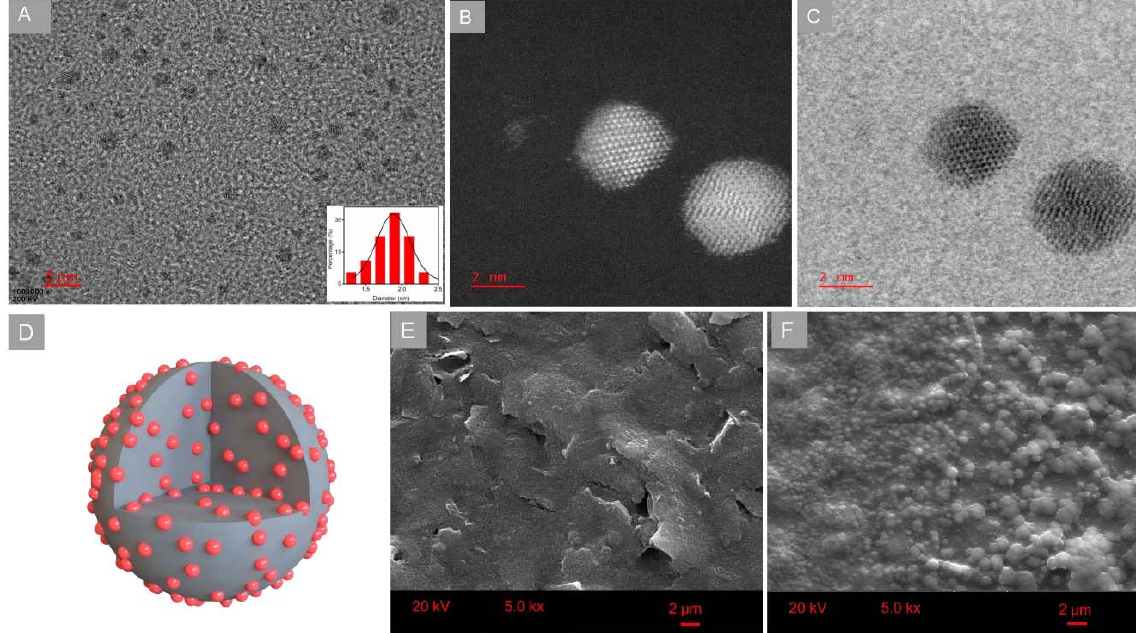
Figure 1. ( A ) TEM image, ( B ) HAADF-STEM and ( C ) ABF-STEM images of GCDs and the ( D ) structure of GCDs. SEM images of ( E ) bare and ( F ) GCD-doped chitosan modified working electrodes.